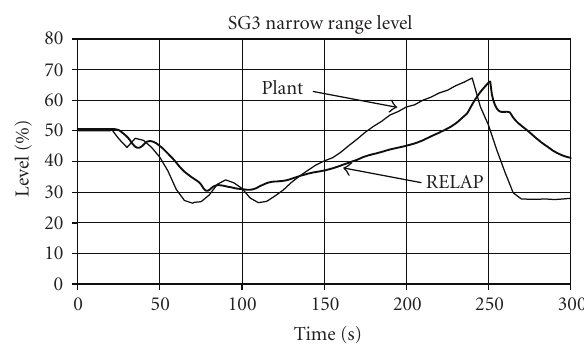
Figure 3: SGs narrow range level (FW turbo-pump generic tran- sient).